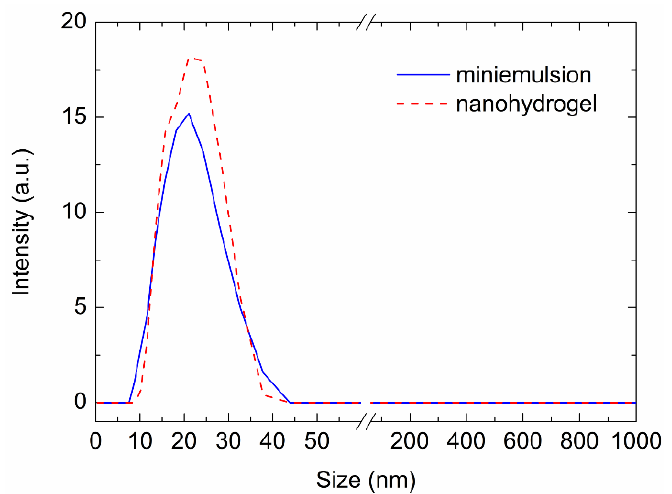
Figure 2. Comparison between miniemulsion droplet (sample M6) and nanohydrogel (sample H2) dimensional distributions obtained by DLS. The templating effect of miniemulsion is highlighted by the overlapping of the two